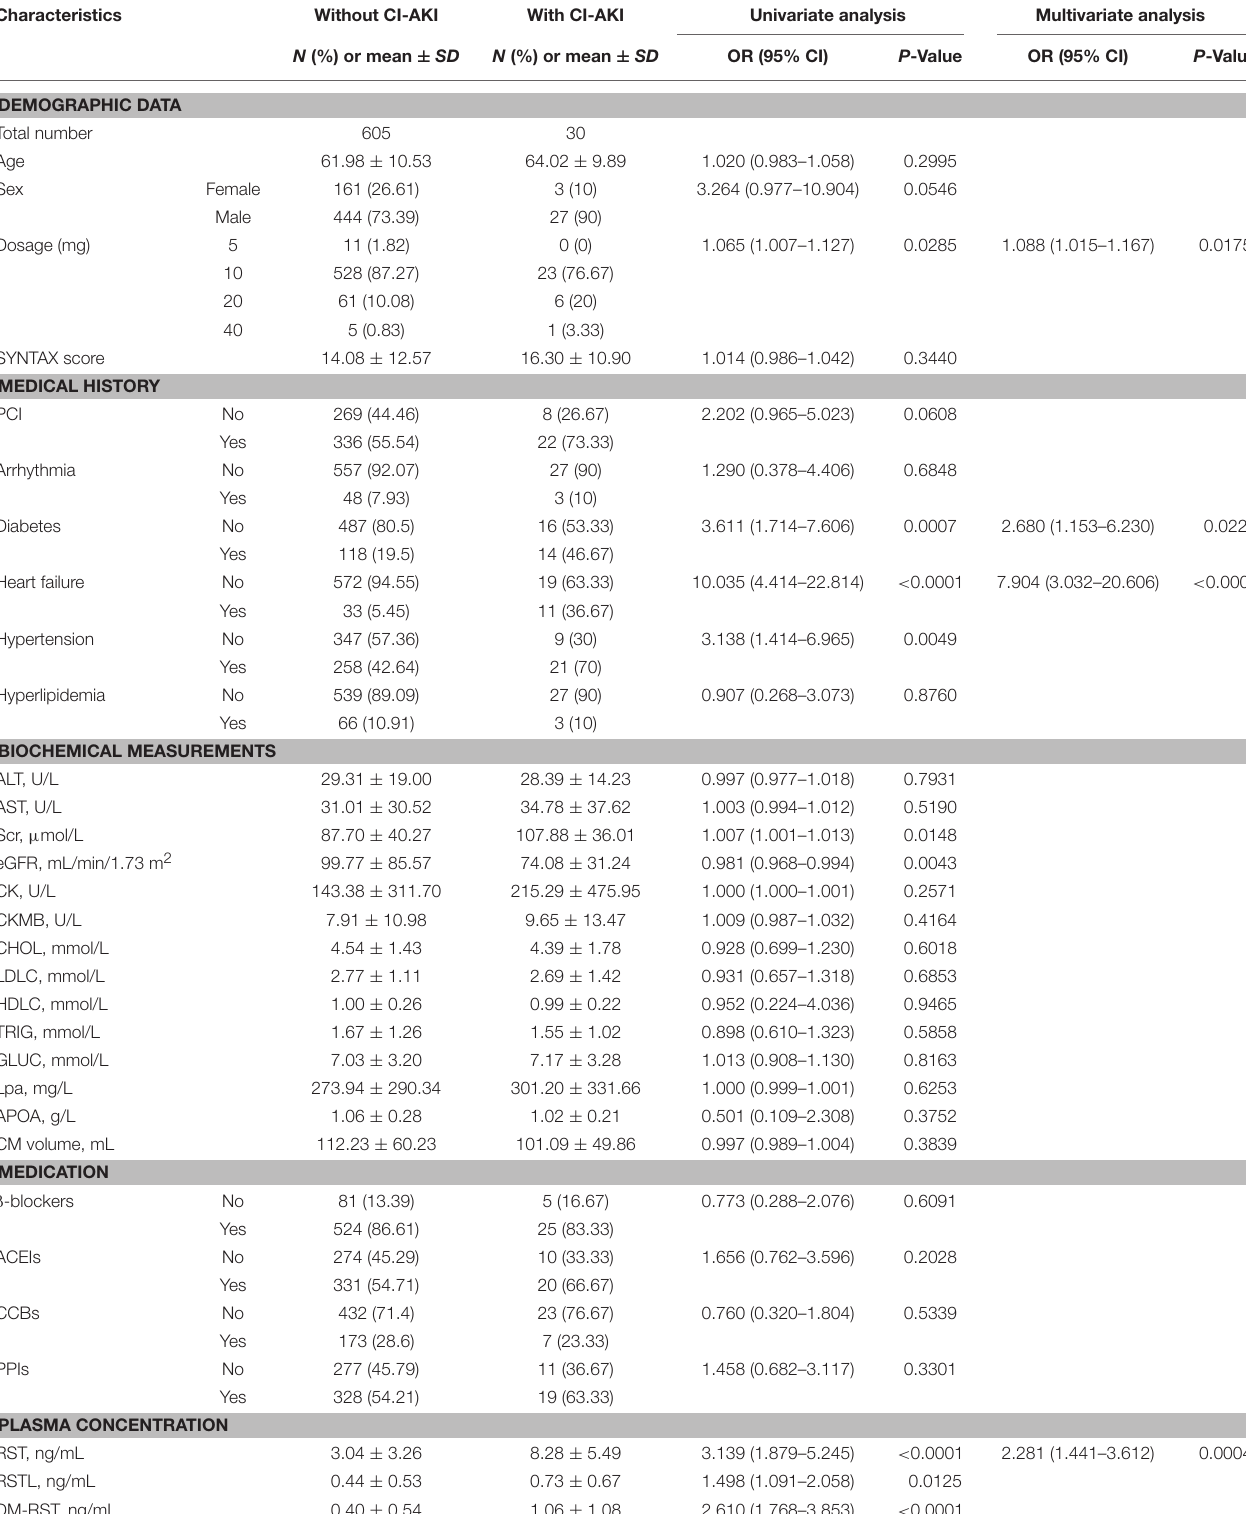
TABLE 4 | Effects of baseline characteristics and plasma concentrations of RST and its metabolites on CI-AKI in stage II. Characteristics Without CI-AKI With CI-AKI Univariate analysis Multivariate